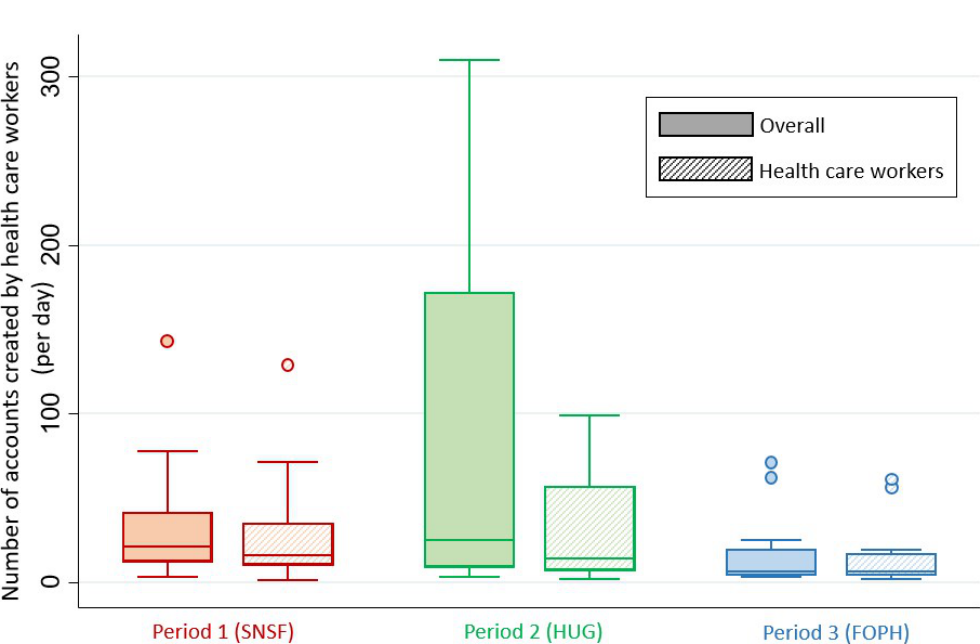
Figure 2. Box plot detailing the number of accounts created per day during each period. SNSF: Swiss